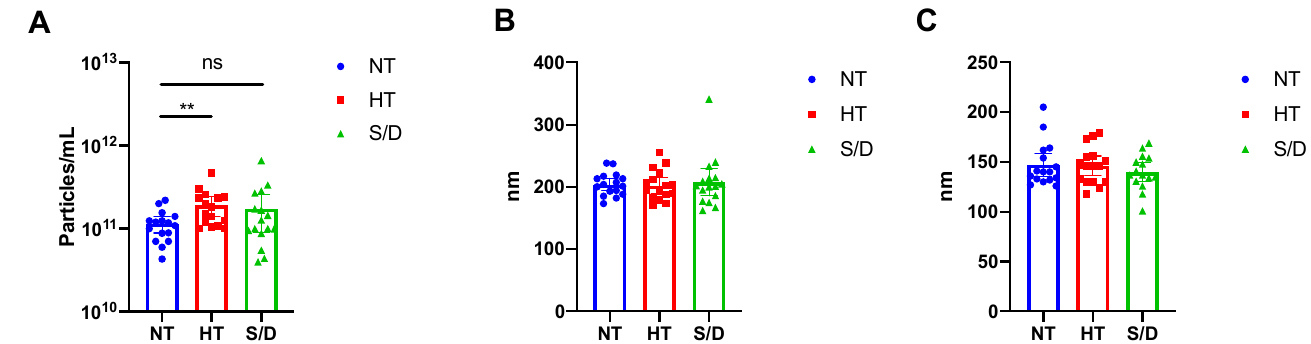
Figure 1. Nanoparticle Tracking Analysis (NTA) of EVs isolated by ultracentrifugation from untreated (NT), heat-treated (HT) and solvent/detergent (S/D) treated healthy sera. N = 16. ( A ): mean particle count with 95%CI. ( B ): mean particle size with 95% CI. ( C ): median particle size with 95% CI. Significance level: p < 0.05; ** = p < 0.01. Representative results of NTA analysis for NT, HT and S/D samples are reported in Figure S1, Supplementary Material.